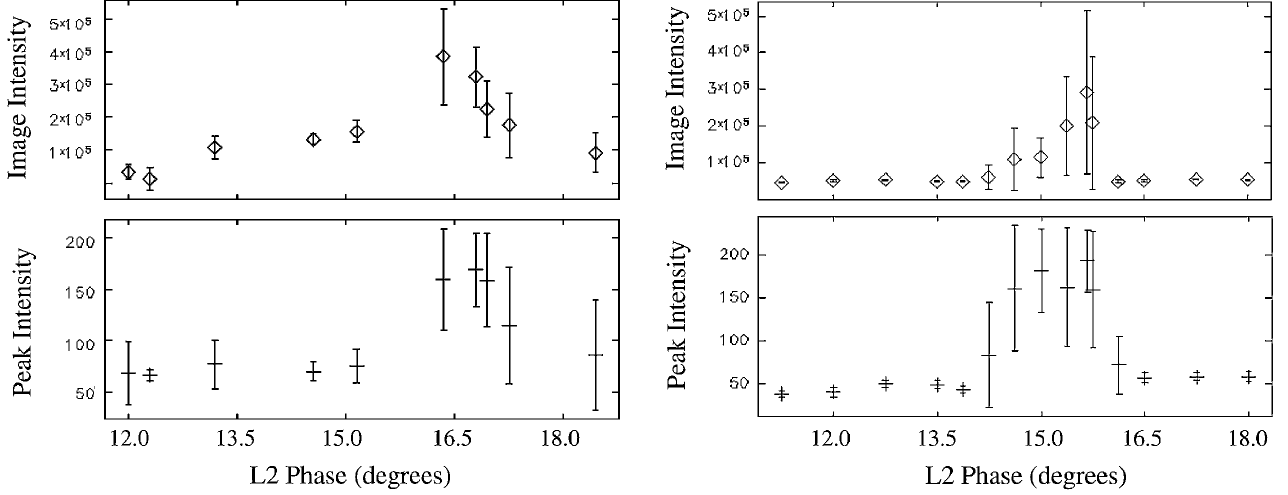
FIG. 9. Plot of the OTR image intensity integrals (top) and OTR peak intensities (bottom) at 375 MeV using automated postprocessing versus L2 phase. The OTR enhancements occur near the same phase as the observed FIR CTR signal